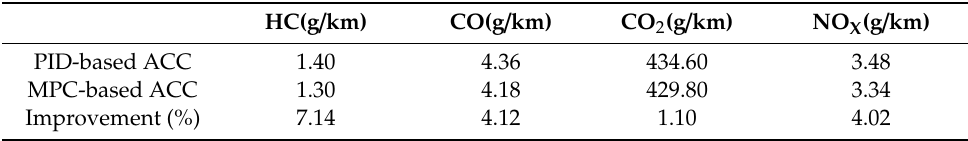
Table 2. Emissions results in Scenario